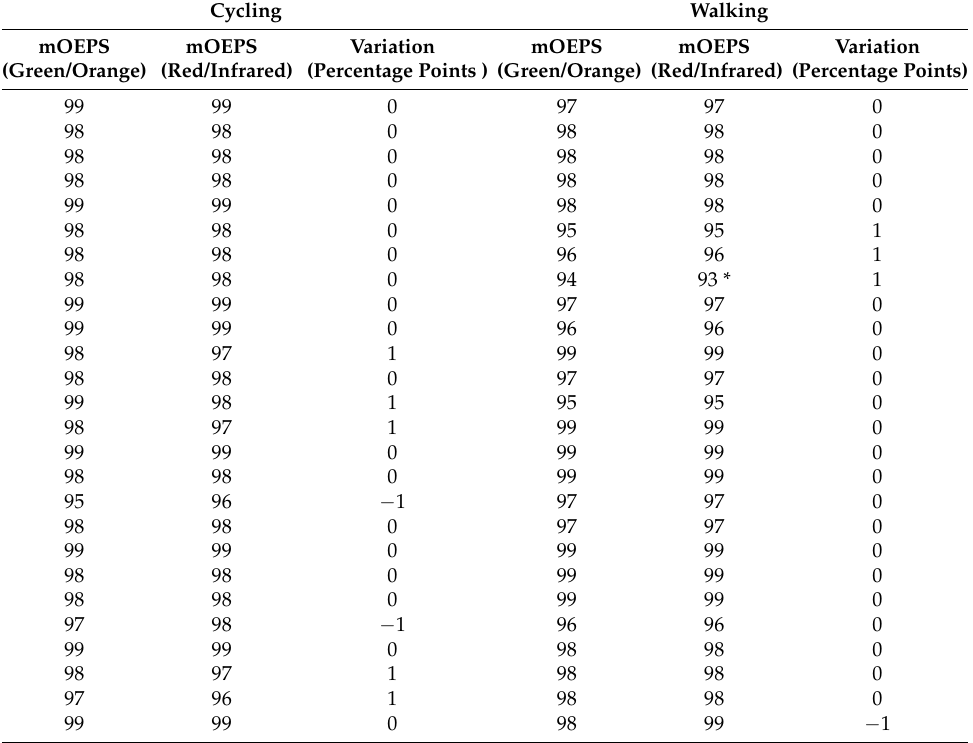
Table 3. Typical SpO 2 (percentage points) comparison between the green/orange and red/infrared illuminations of mOEPS.The star sign (*) identifies the readings of SpO 2 that are of a very low value due to a subject’s sweaty skin during the experiment